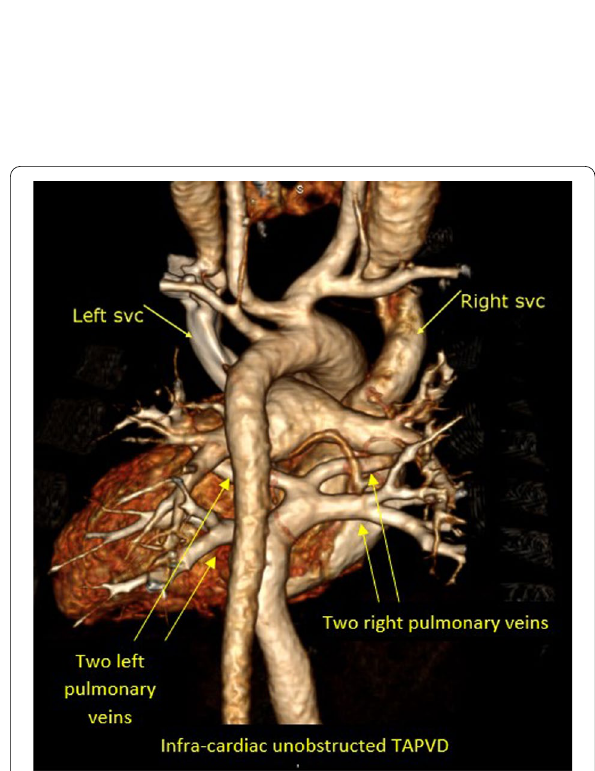
Fig. 3 3D volume rendering image showing total anomalous pulmonary venous drainage unobstructed infra-cardiac type of the four pulmonary